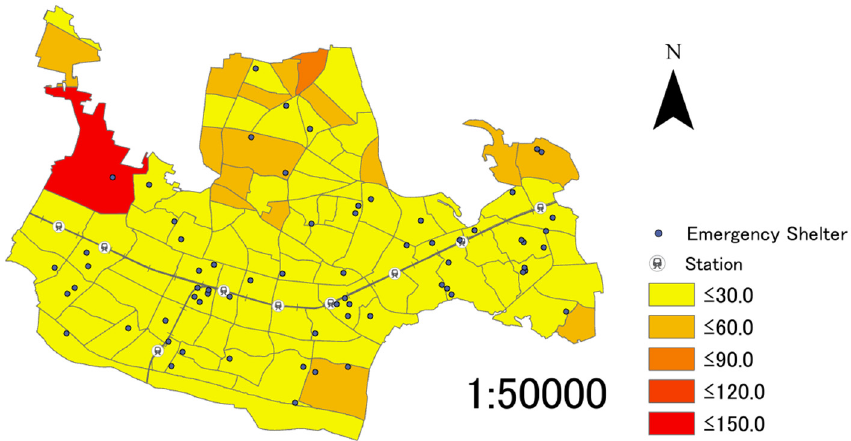
Figure 1. Result for Chofu City without a weighted coefficient.